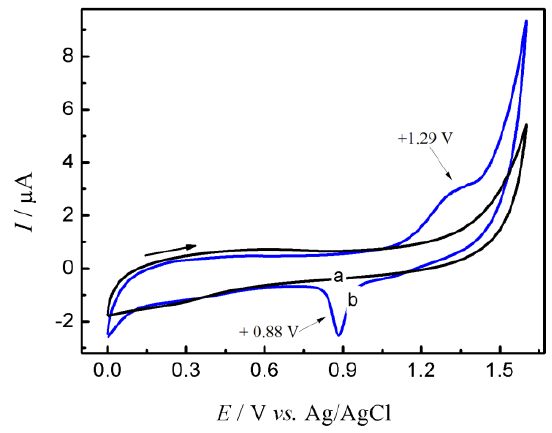
Figure 2. Cyclic voltammetry characterization in 0.1 mol L −1 of H 2 SO 4 with a scan rate of 50 mV s −1 for the electrodes: (a) GC/rGO and (b) GC/rGO-AuNPs.